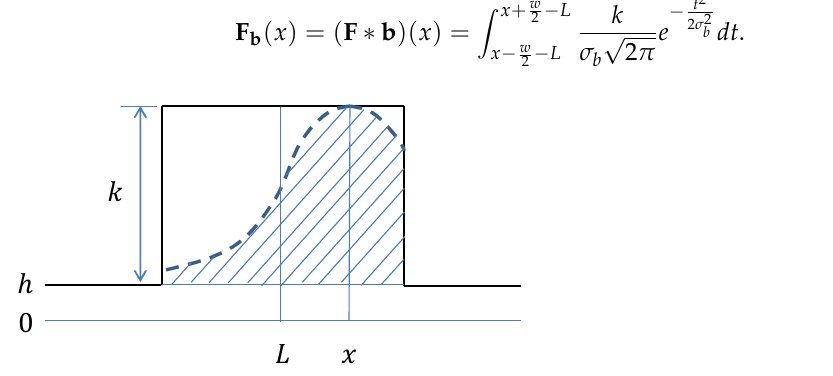
Figure 2. Gaussian blur for a line